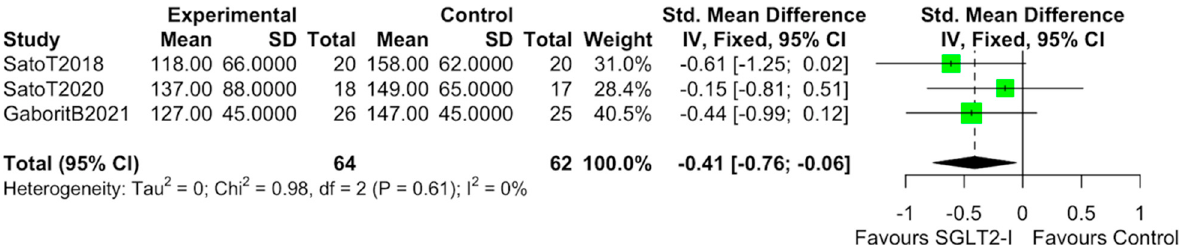
Figure 5. Effect of SGLT2-i therapy on TG. Fixed − effects, standardized mean difference (SMD), 95% confidence intervals (CI), and I2 statistics.